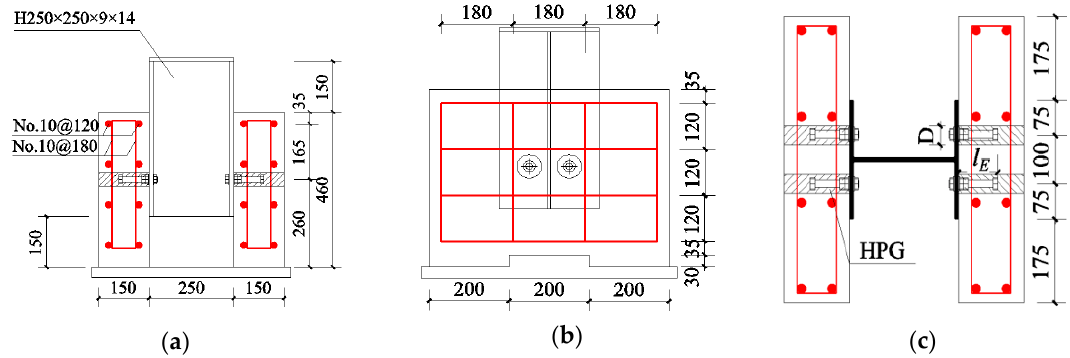
Figure 2. Details of the specimens (Units: mm): ( a ) front view; ( b ) side view; ( c ) top view.